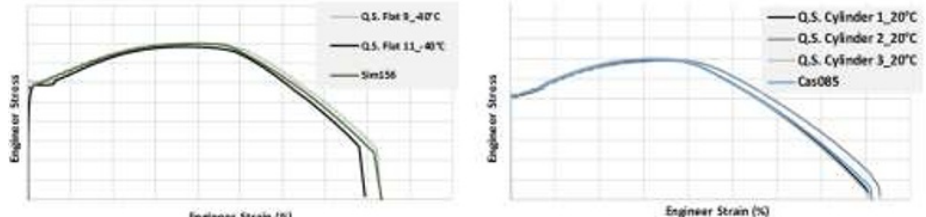
Fig. 3. Quasi-static tests results on different sample geometries and temperatures. Comparison with numerical simulations with the calibrated material model.